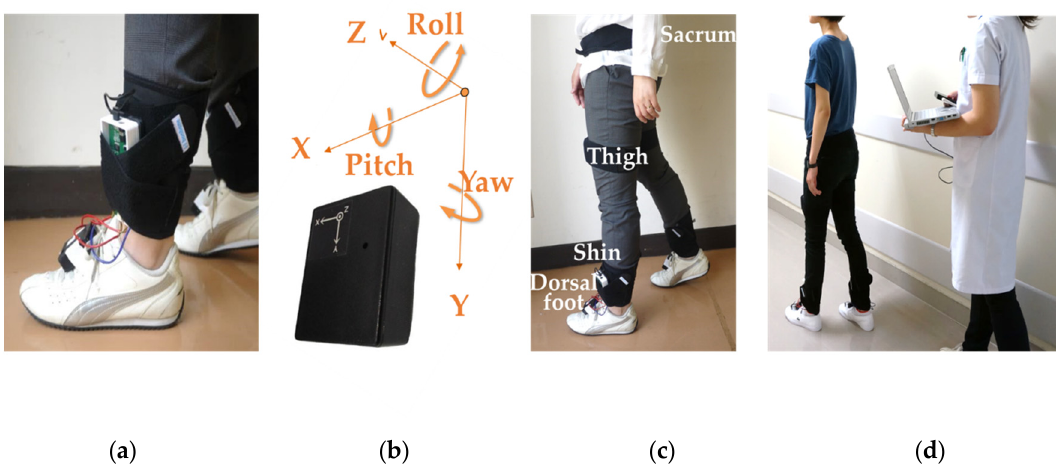
Figure 1. Attachment of sensors. ( a ) The Central Processing Unit (CPU) circuit board of the external force sensors was attached to the shin; ( b ) orientation of the motion sensors; ( c ) motion sensors were attached to the sacrum, thigh, shin, and dorsal foot; ( d ) the personal computer and CPU circuit board were connected wirelessly.